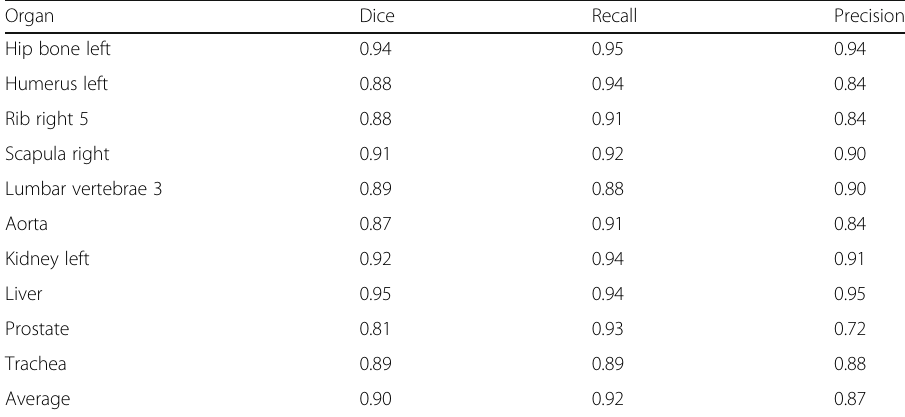
Table 3 Mean Dice index, recall, and precision per organ on an independent test set of 10 patients (5 male/5 female) Organ Dice Recall Precision